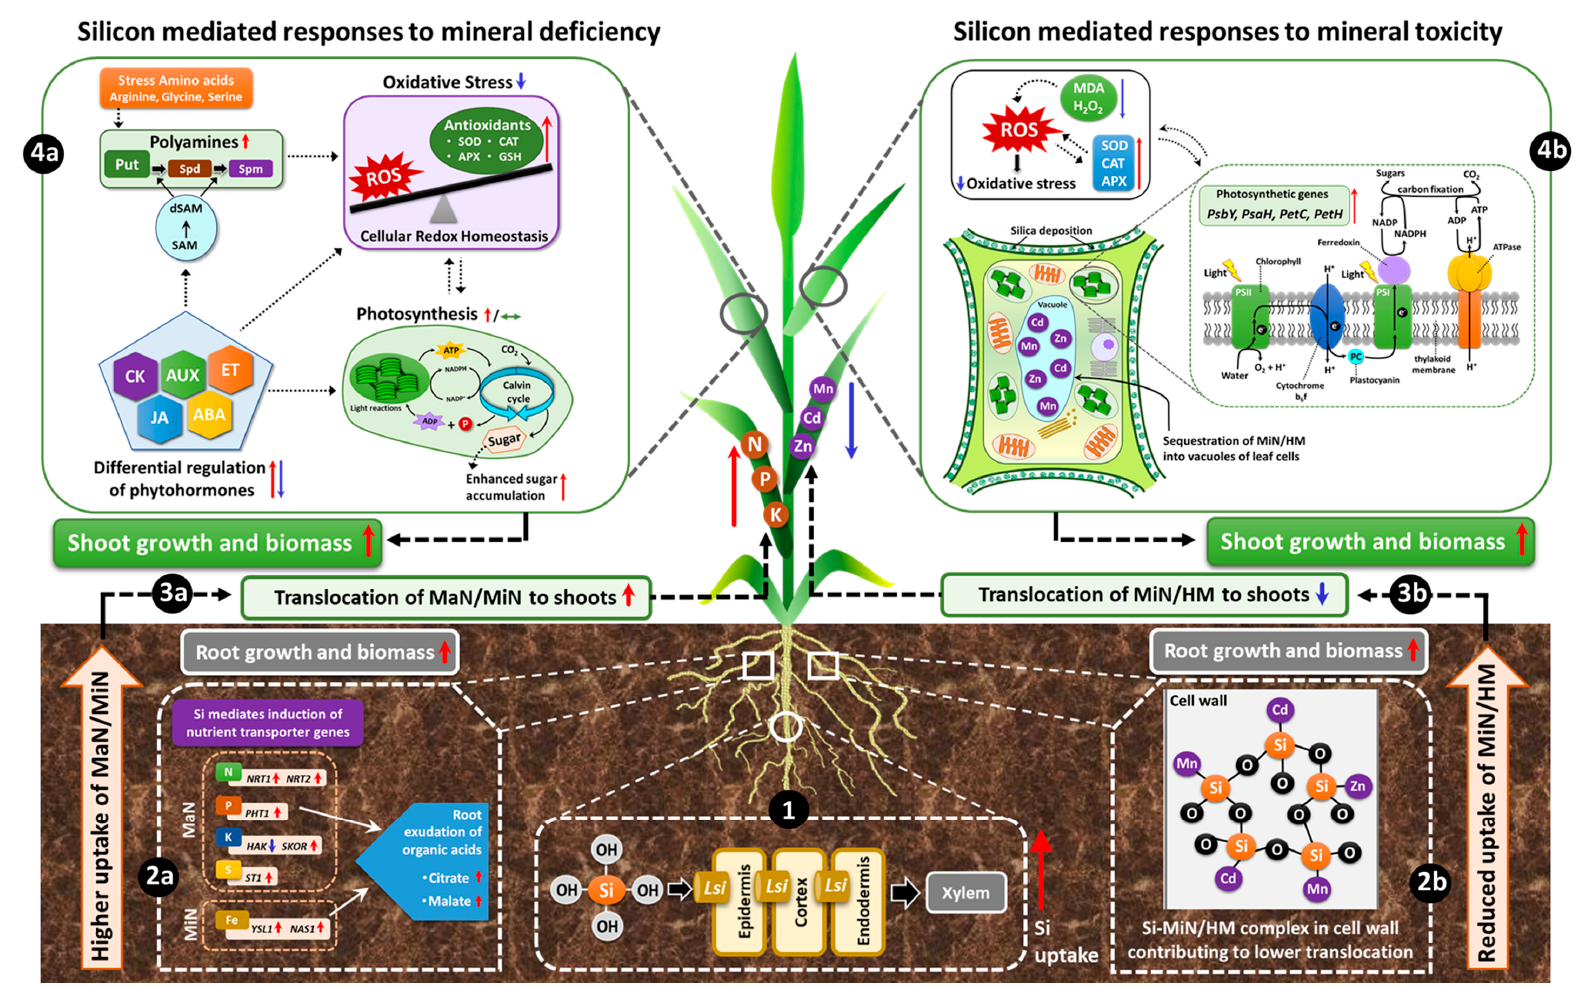
Figure 2. Schematic model displaying Si-mediated shared responses to nutritional stresses. The initial response to Si under nutritional stress is the uptake of supplied Si, mediated by induction of respective Lsi transporters in the roots ( 1 ). Consequently, under nutrient deficiency, Si induces the genes encoding the uptake and